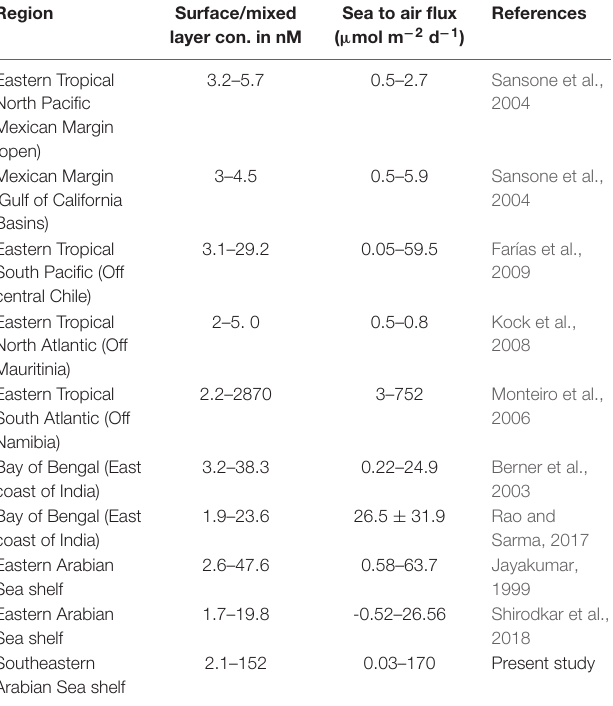
TABLE 2 | Comparison of CH 4 concentration from natural coastal hypoxic systems. Region Surface/mixed layer con. in